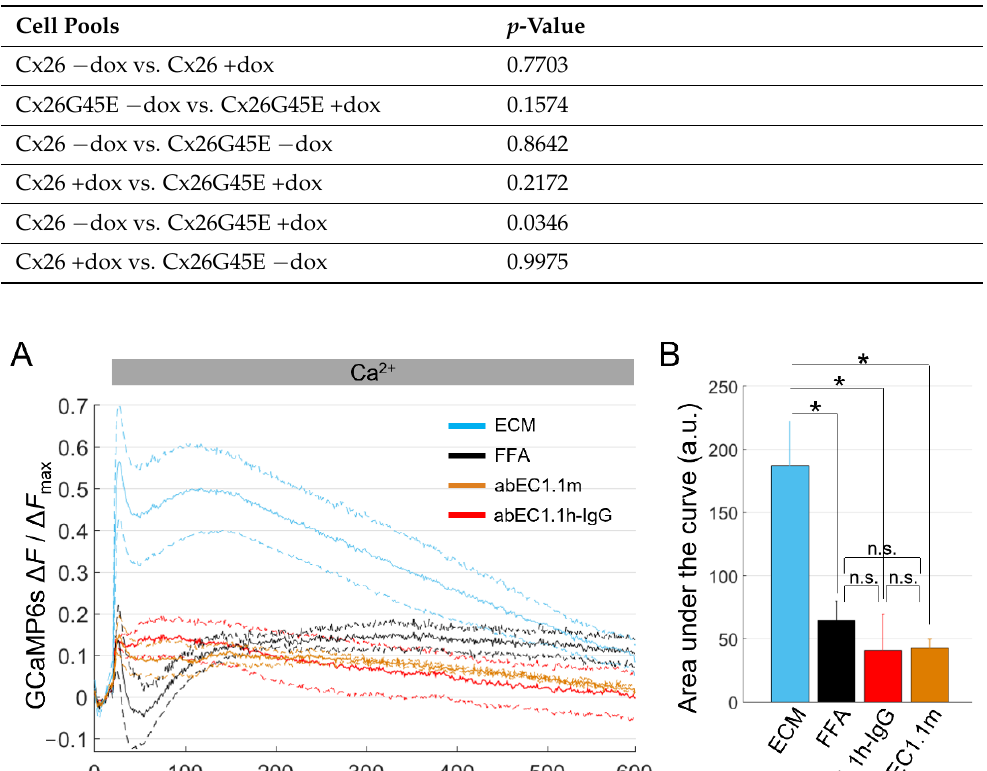
Figure 6. Ca 2+ uptake assay in HaCaT-Cx46-GCaMP6s cells. ( A ) The mean normalized Ca 2+ uptake traces (solid lines) ± s.e.m. (dashed lines) obtained from HaCaT-Cx46-GCaMP6s in ECM (green, n = 5), ECM plus FFA (100 µM, black, n = 6), ECM plus 0.1 µM anti-Cx46 mAb Ab17396 (orange, n = 3), ECM plus 1 µM Ab17396 (gray, n = 3) or ECM plus 10 µM Ab17396 (red, n = 3). ( B ) Areas subtended by normalized Ca 2+ uptake traces (mean ± s.e.m.) in the time interval between t = 20 s and t = 590 s for some of the data shown on the left; 0.1 µM Ab17396 and 1 µM Ab17396 conditions were omitted due to the negative swing; this was never observed with other inhibitors or in control conditions.